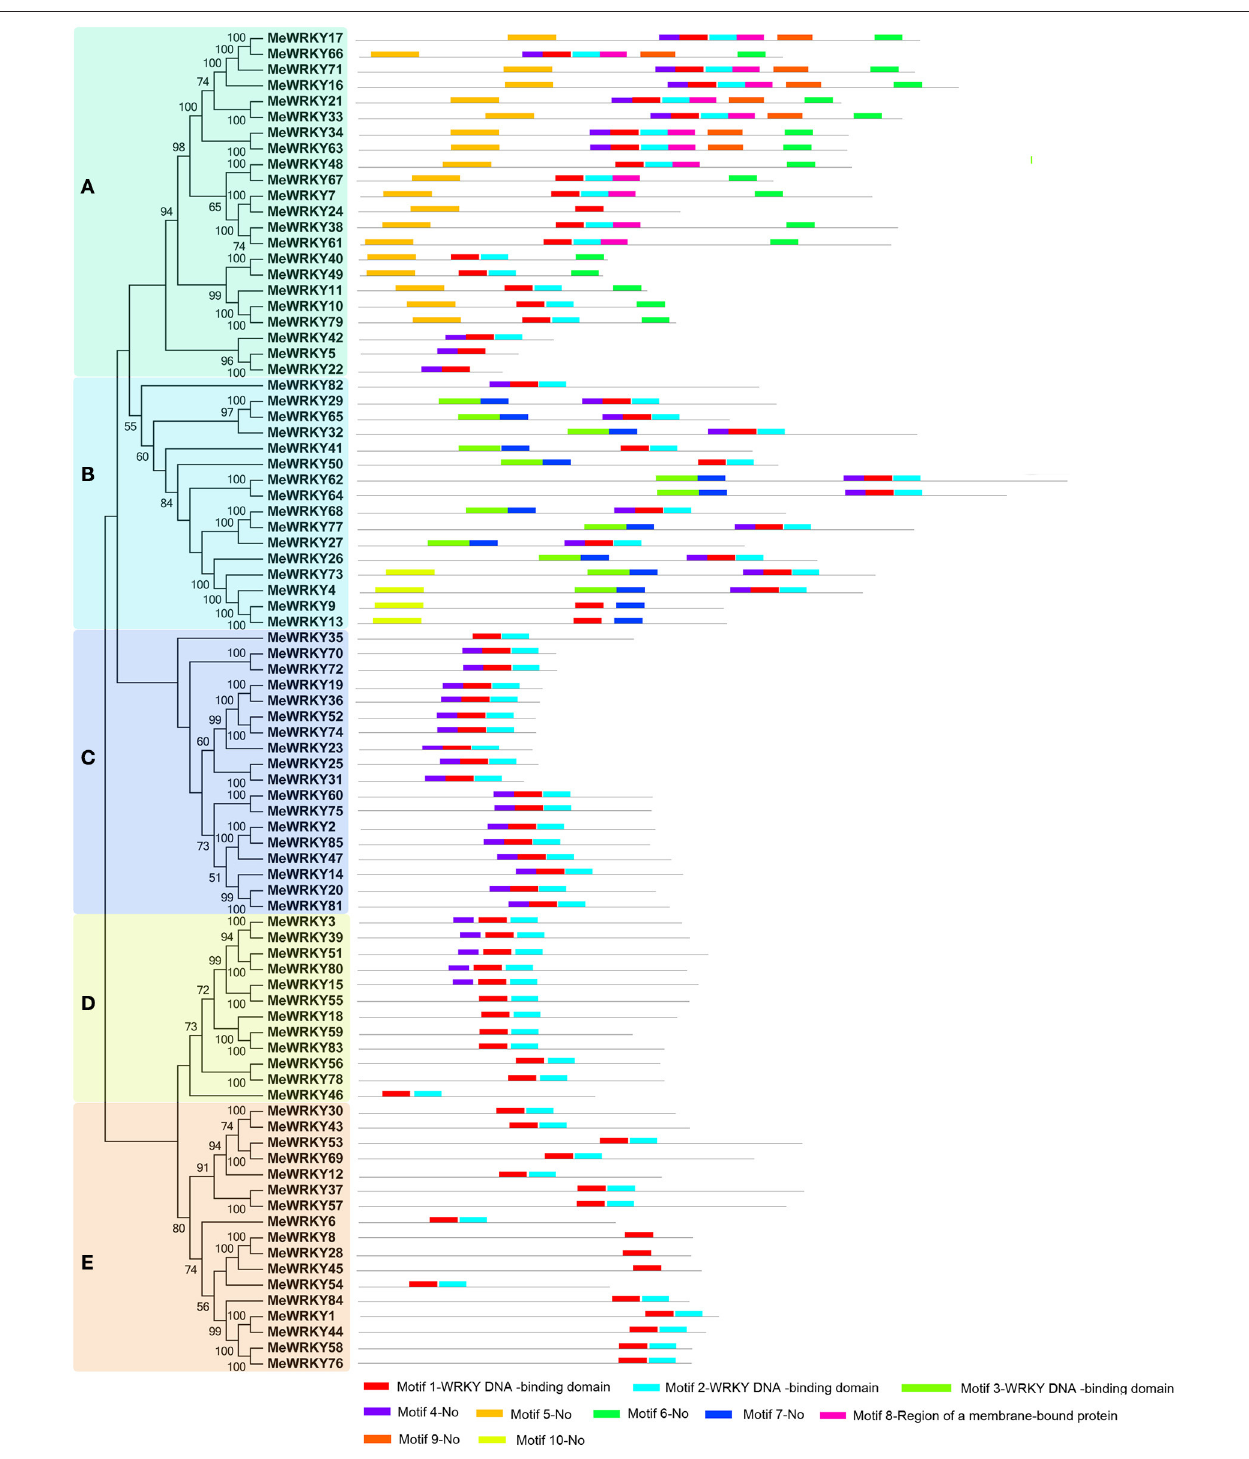
FIGURE 2 | Conserved motifs of MeWRKY proteins according to the phylogenetic relationship. The NJ tree was constructed with full amino acids of cassava WRKYs using ClustalX 2.0 and MEGA5 with 1000 bootstraps. The conserved motifs in the MeWRKY proteins were identified by MEME. Gray lines represent the non-conserved sequences, and each motif is indicated by a colored box numbered at the bottom. The length of motifs in each protein was exhibited proportionally. (A–E) indicates different groups of WRKY family in cassava.